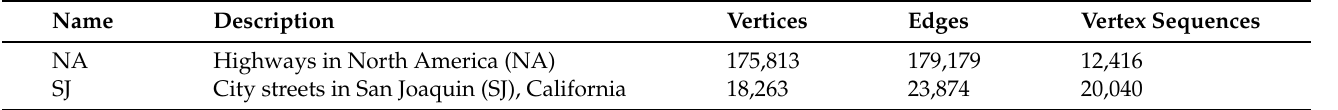
Table 7. Real-world roadmaps [40].